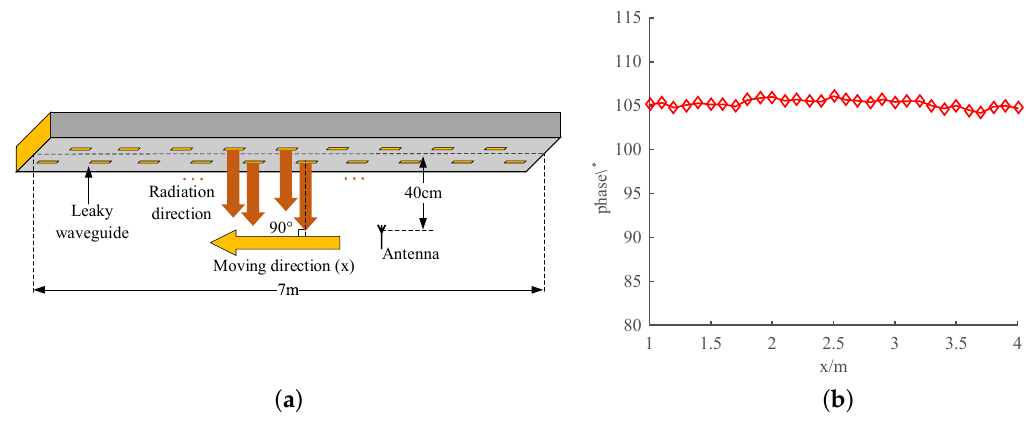
Figure 2. Phase distribution of the leaky waveguide method: ( a ) Configuration of leaky waveguide and receiving antenna. ( b ) The phase distribution of different measuring